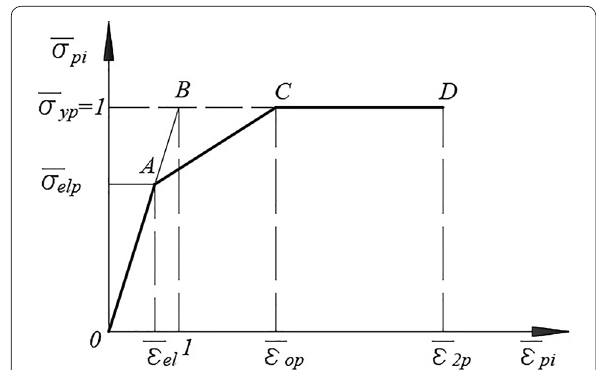
Fig. 2 Generalized calculation diagram of the steel shell operation.